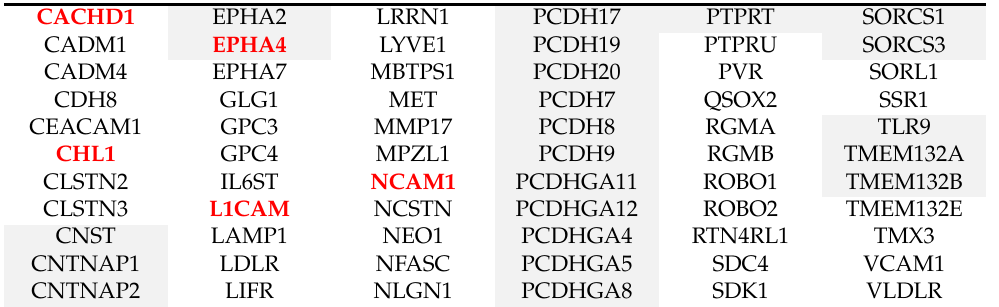
Table 2. The 25 BACE1 substrates differentially expressed in Alzheimer’s disease (AD). Identified from BACE1 experimental dependent proteins overlaid with BACE1 predicted substrate [37], subse- quently compared against proteins differentially expressed in brain samples from individuals with AD and other non-AD diseases (epilepsy, stroke, traumatic brain injury, experimental autoimmune en- cephalitis). BACE1 substrates that are AD-specific are shaded grey. Validated and well-characterised substrates are shown in red. Details can be searched on GeneCards: https://www.genecards.org/